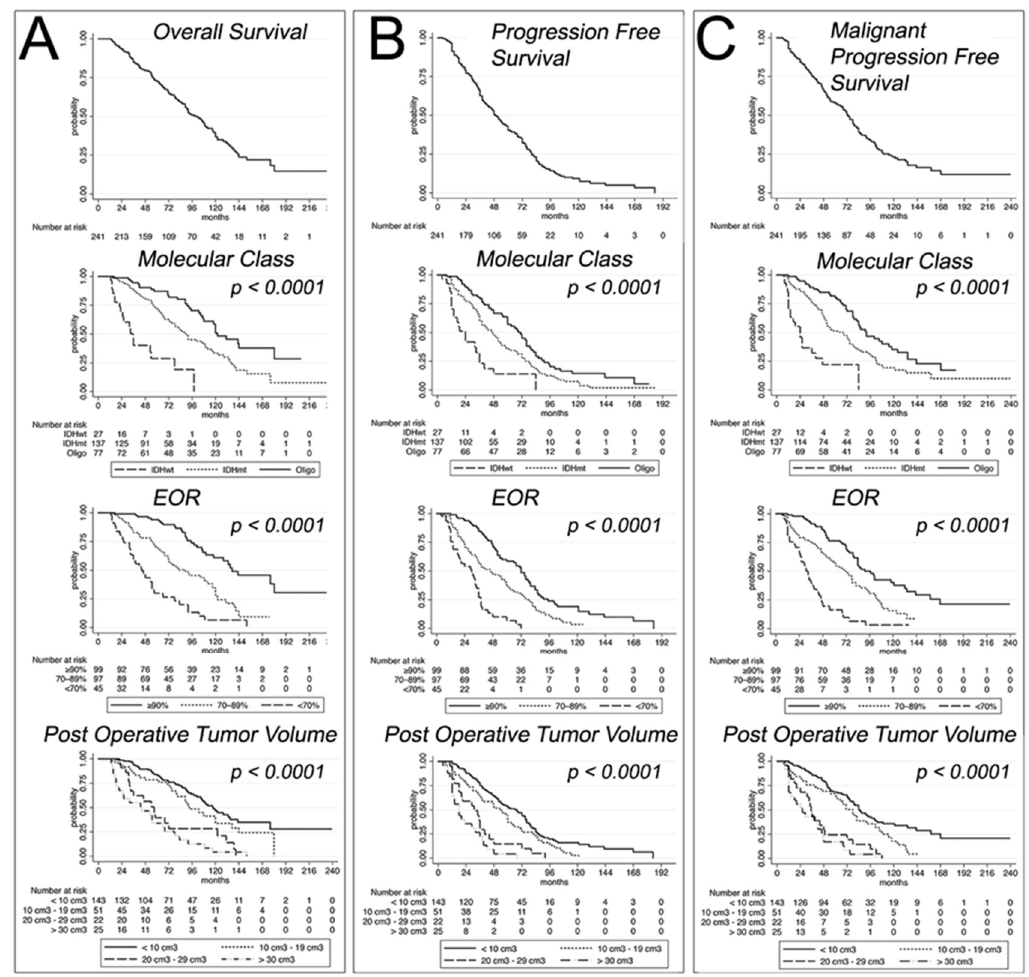
Figure 1. Kaplan–Meyer estimates of OS ( A ), PFS ( B ), and MPFS ( C ) of 241 patients stratified according to molecular class, EOR, and post-operative tumor